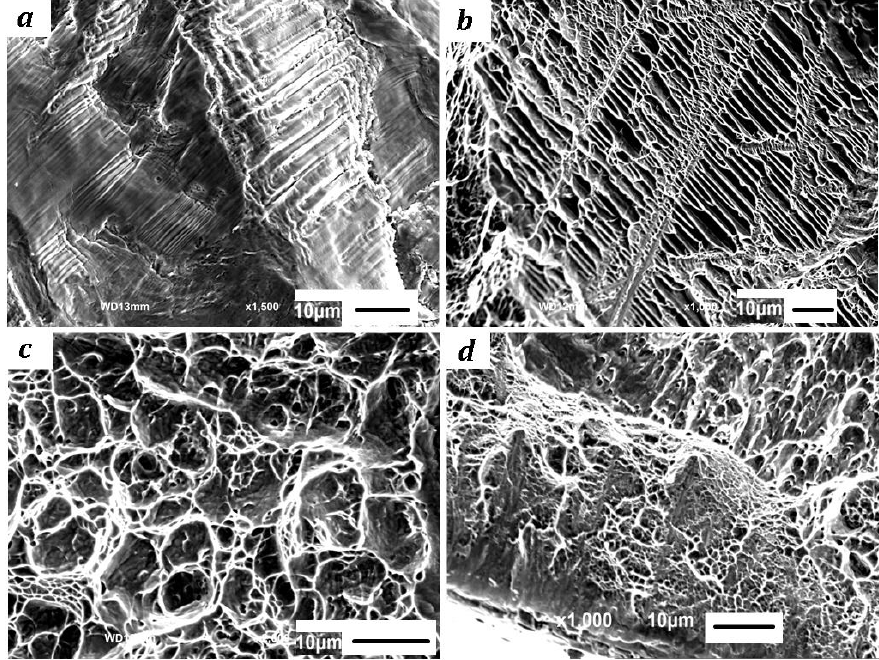
Figure 9. Observation of the fracture surface: ( a ) Sliding lines on a white band; ( b ) Quasi-cleavage plane; ( c ) Equal-axis ductile dimples of un-UNSMed specimen; ( d ) Parabolic fossae and oval toughening nests of SSA-UNSM beneath the surface.